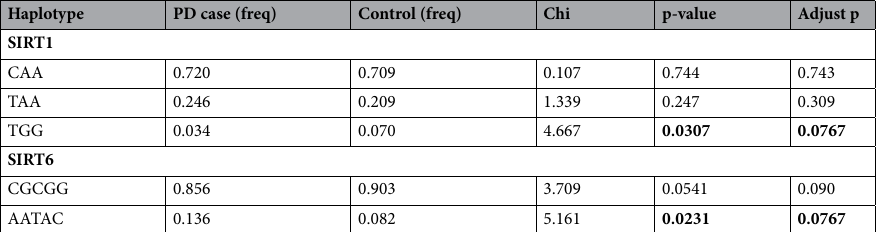
Table 2. Haplotype frequencies in PD cases and controls. Haplotype block 1 is identified by rs3758391– rs3740051–rs3818292 in SIRT1 gene, and haplotype block 2 is identified by rs350843–rs350844–rs107251– rs350845–rs350846 in SIRT6